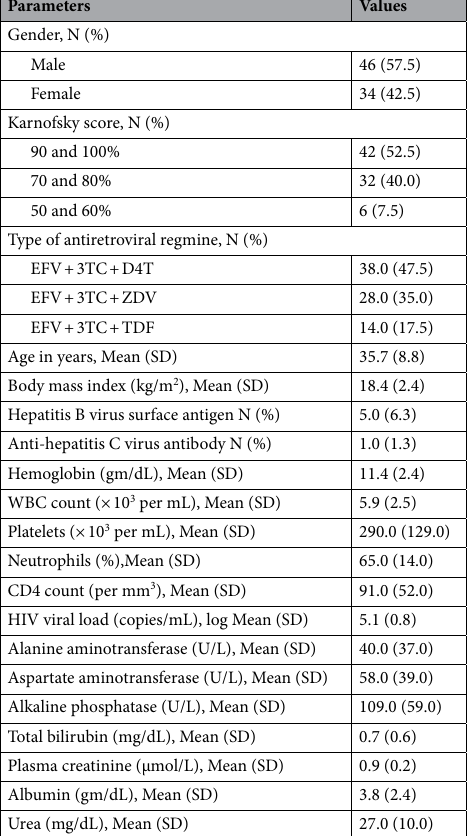
Table 1. Baseline demographic, clinical and laboratory characteristics of study participants [3TC— Lamivudine; D4T—Stavudine; EFV—Efavirenz; N—Number; SD—Standard deviation; TDF—Tenofovir; ZDV—Zidovudine].